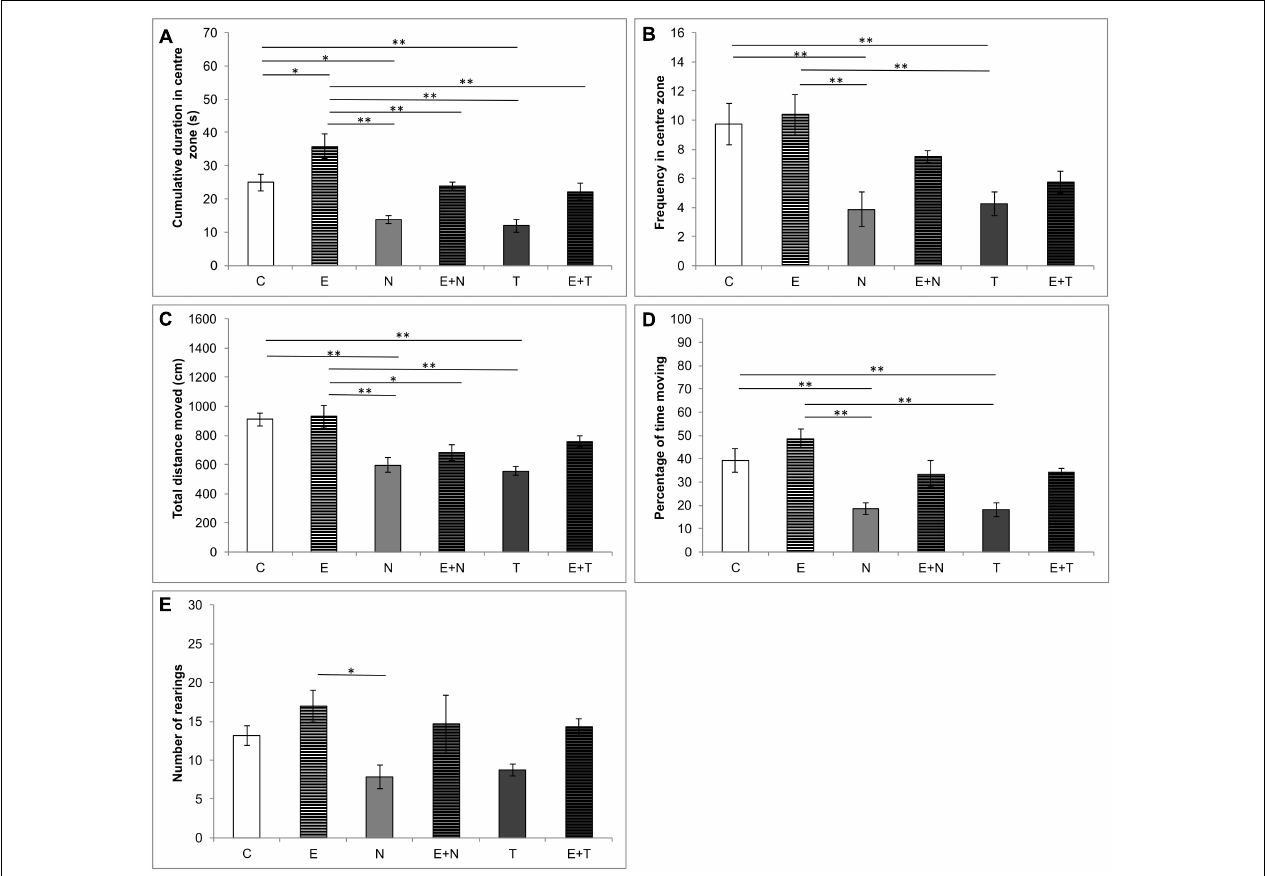
FIGURE 1 | Parameters calculated from the open field test. (A) Cumulative duration in the center zone; (B) Frequency in the center zone; (C) Total distance moved; (D) Percentage of time moving; (E) Number of rearing; (C, control group; E, exercise group; N, nandrolone-decanoate group; E+N, exercise plus nandrolone-decanoate group; T, testosterone-enanthate group; E+T, exercise plus testosterone enanthate group). Bars represent means ± SEM, ∗ denotes a significant difference p ≤ 0.025, ∗∗ denotes a significant difference p ≤